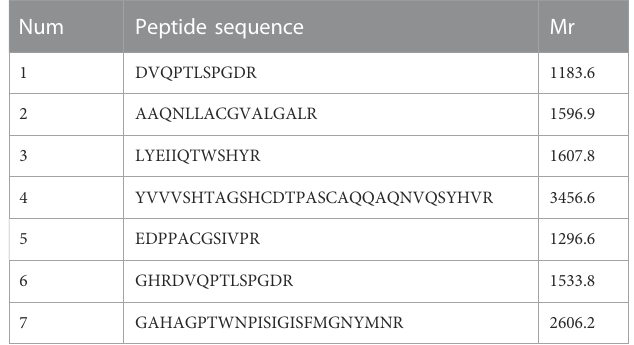
TABLE 1 Seven bioactive